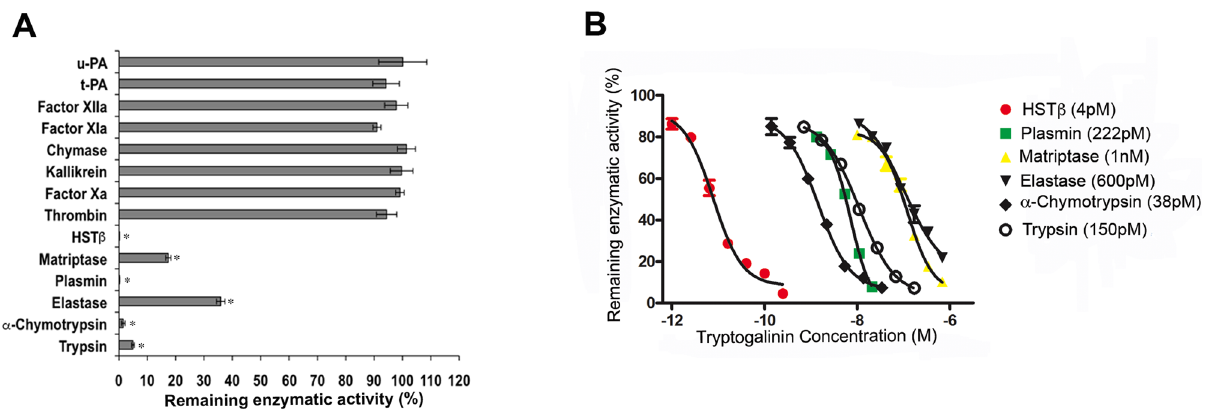
Figure 2. A–B. Titration of the targeted serine proteases with the recombinant protein. An inhibition screening (A) using 14 vertebrate serine proteases – the asterisk denotes with p-values # 0.05 and # 50% inhibition. Inhibition curves (B) were produced for the targeted enzymes by plotting the concentration of the inhibitor and the estimated percentage of the enzymatic activity. Since the amount of enzyme used in the assay varies for each protease, we represent the molar excess of the I. scapularis Kunitz peptide to achieve 50% inhibition of the respective enzyme, when compared to the amount of enzyme used in each assay (also see Materials and Methods).